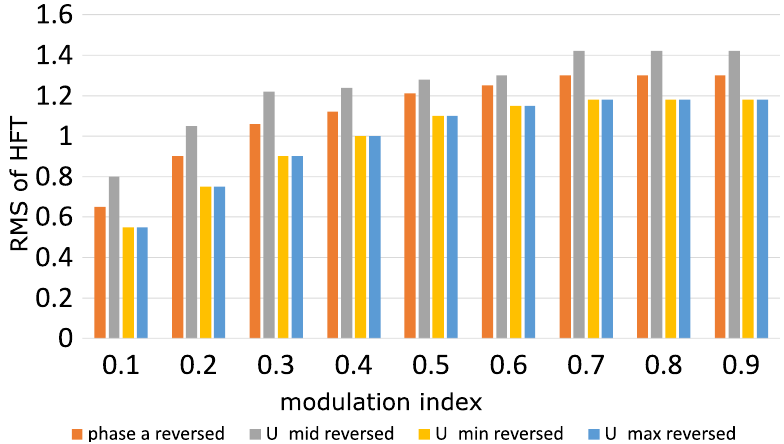
Figure 9. RMS value of the HFT in a fundamental cycle for four different reversed switching combi- nations.